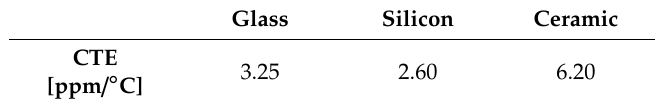
Table 4. Coe ffi cients of thermal expansion of packaging materials at room temperature.